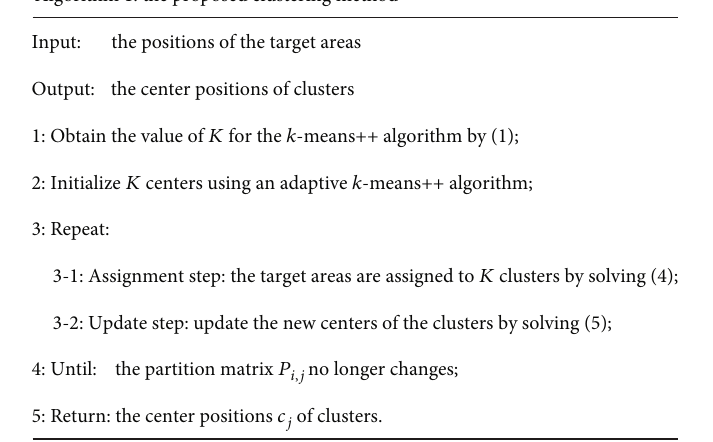
Algorithm 1: the proposed clustering method